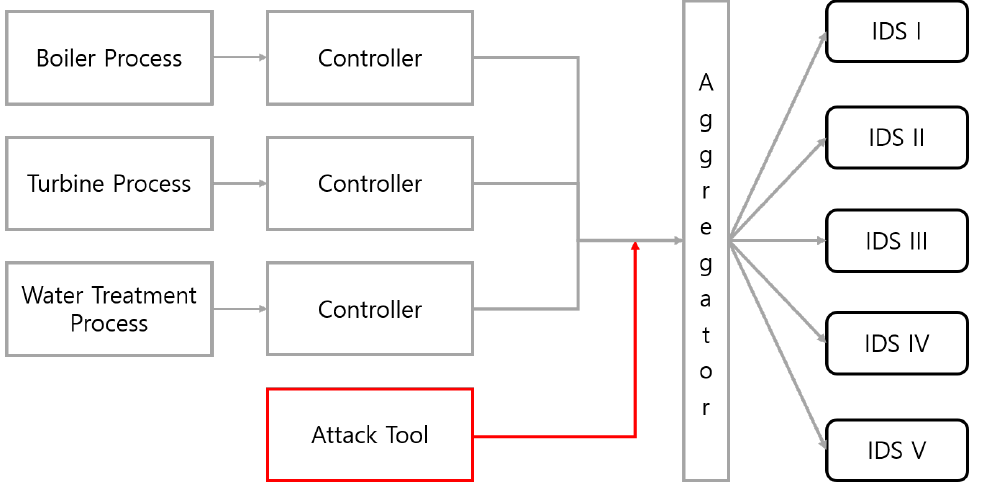
Figure 5. Outline of HAI testbed. Table 2. Collectable security logs from five